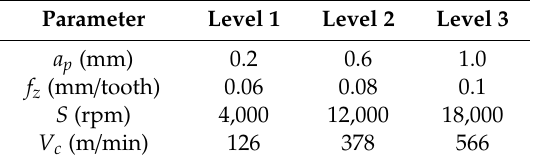
Table 2. Machining parameters and levels for cutting coefficient calculation tests.